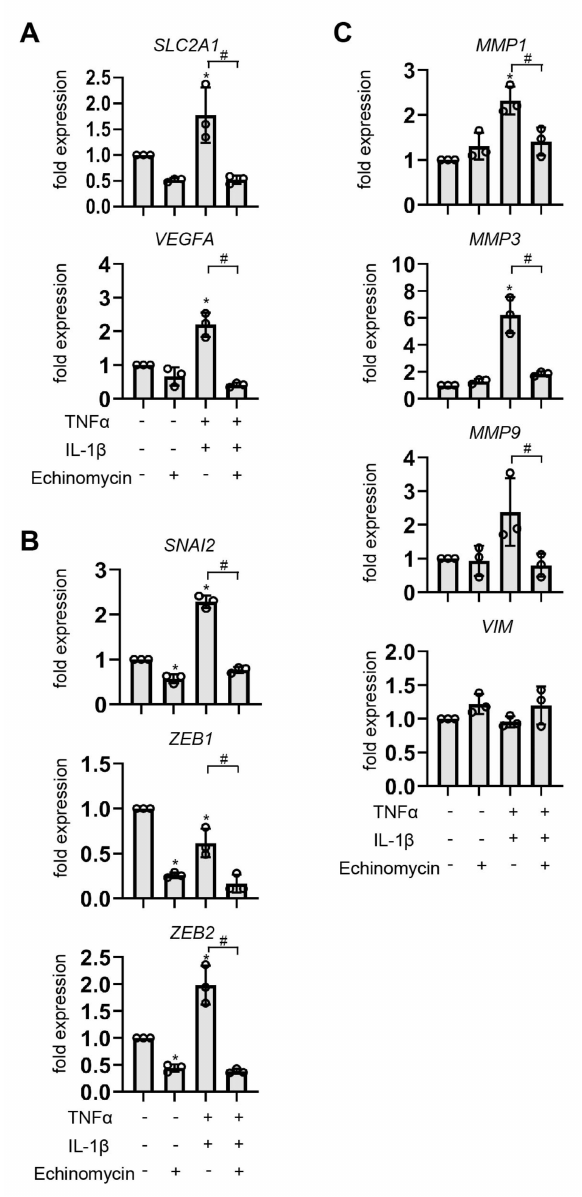
Figure 8. Effect of HIF-1 suppression by echinomycin on EMT-related genes. ( A – C ) EM-E6/E7/TERT cells were cultured under 20% O 2 conditions for 8 h in medium containing either control or pro- inflammatory cytokines (500 ng/mL TNF α and 100 ng/mL IL-1 β ) and/or echinomycin (10 nmol/L). Total RNAs were analyzed by semi-quantitative RT-PCR and calculated after normalization to EF-1 α total RNA levels. Data represent the mean ± SD ( n = 3). * p < 0.05 compared to the control. # p < 0.05 for the indicated